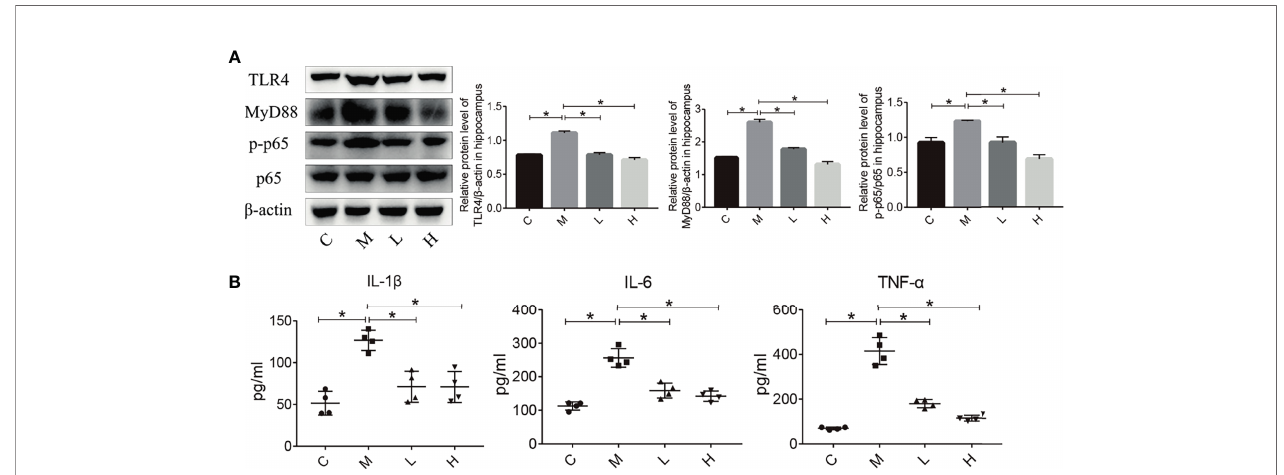
FIGURE 4 | The probiotic combination modulated the TLR4/NFkB signalling pathway and hippocampal in fl ammation in SAMP8 mice. (A) The effect of the probiotic combination on the expression levels of TLR4, MyD88, p-p65 and p65 in the hippocampus. (B) The probiotic combination reduced the levels of the pro-in fl ammatory cytokines IL-1 b , IL-6 and TNF- a . C: control group (n = 4), M: model group (n = 4), L: low-dose probiotics group (n = 4), H: high-dose probiotics group (n = 4). Data are presented as the means ± SD. *p < 0.05.